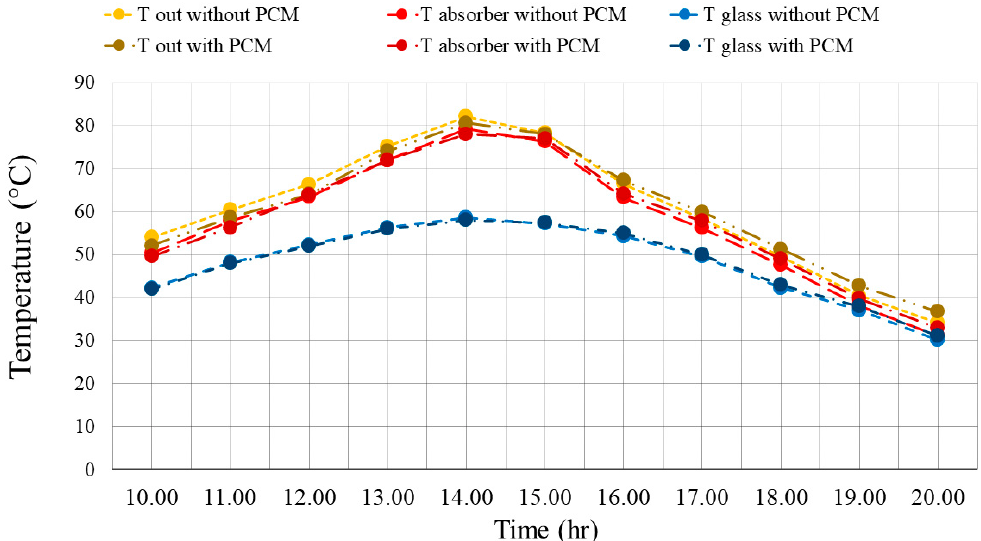
Figure 6. The TEM in three parts of the wall, including the outlet, the absorber plate, and the glass at different times of the day with and without PCM in the summer.